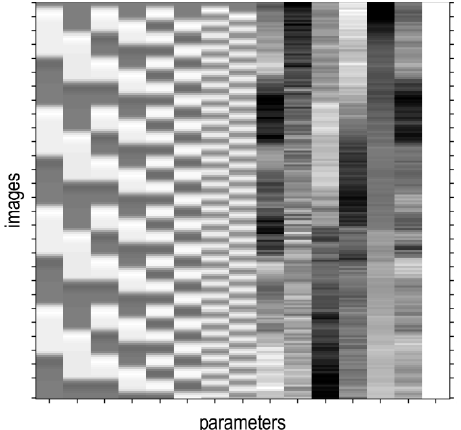
Figure 3. Design matrix for modelling low-frequency fluctuations, containing eight regressors that simulated LFF in 0.01 Hz to 0.08